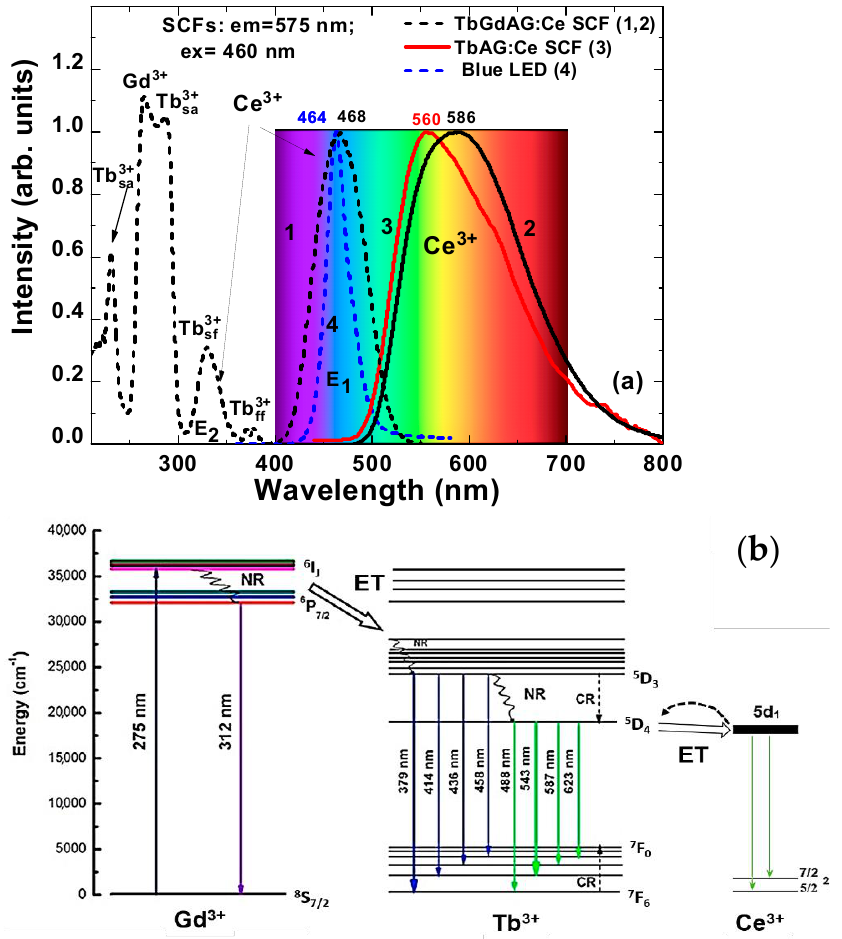
Figure 4. ( a ) RT PLE/PL spectra of TbGdAG:Ce SCF/YAG SC converters (1,2) in comparison with emission spectra of TbAG:Ce SCF counterpart (3) and blue diode (4). ( b ) Energy diagram of cascade Gd 3 + → Tb 3+ ⇆ Ce 3+ ion energy transfer. ET — energy transfer; NR — not radiative transitions; CR — cross-relaxation process of Tb 3+ ions; blue and green arrows — luminescence from 5 D 3 and 5 D 4 levels, respectively.